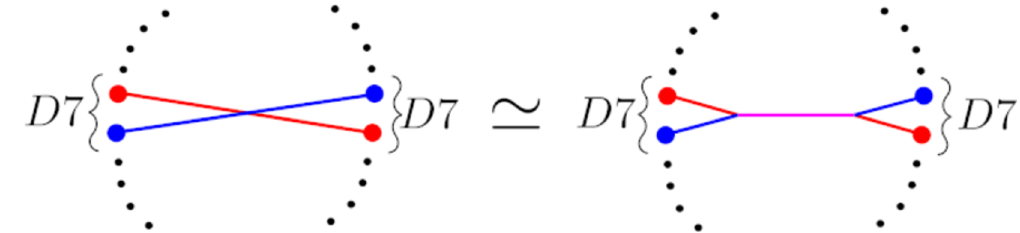
Figure 15 . Analogue of figure 14 but with pair of D7 branes residing at antipodal positions. (almost-)BPS states are the W-boson with central charge Z W and the two dyons (which are exactly BPS [83]) with central charges Z d 1 and Z d 2 = −Z d 1 + Z W , depicted in figure 14.